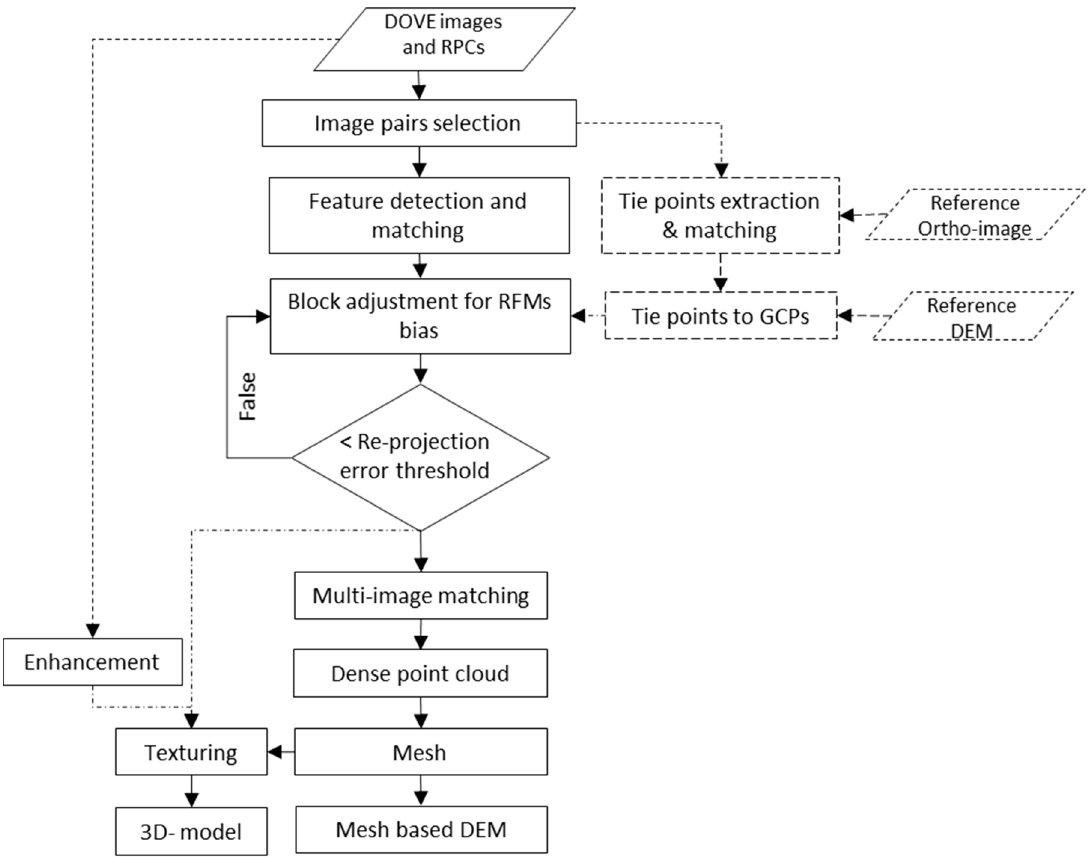
Figure 5. Schematic workflow for PlanetScope image geometry refinement and 3D extraction.